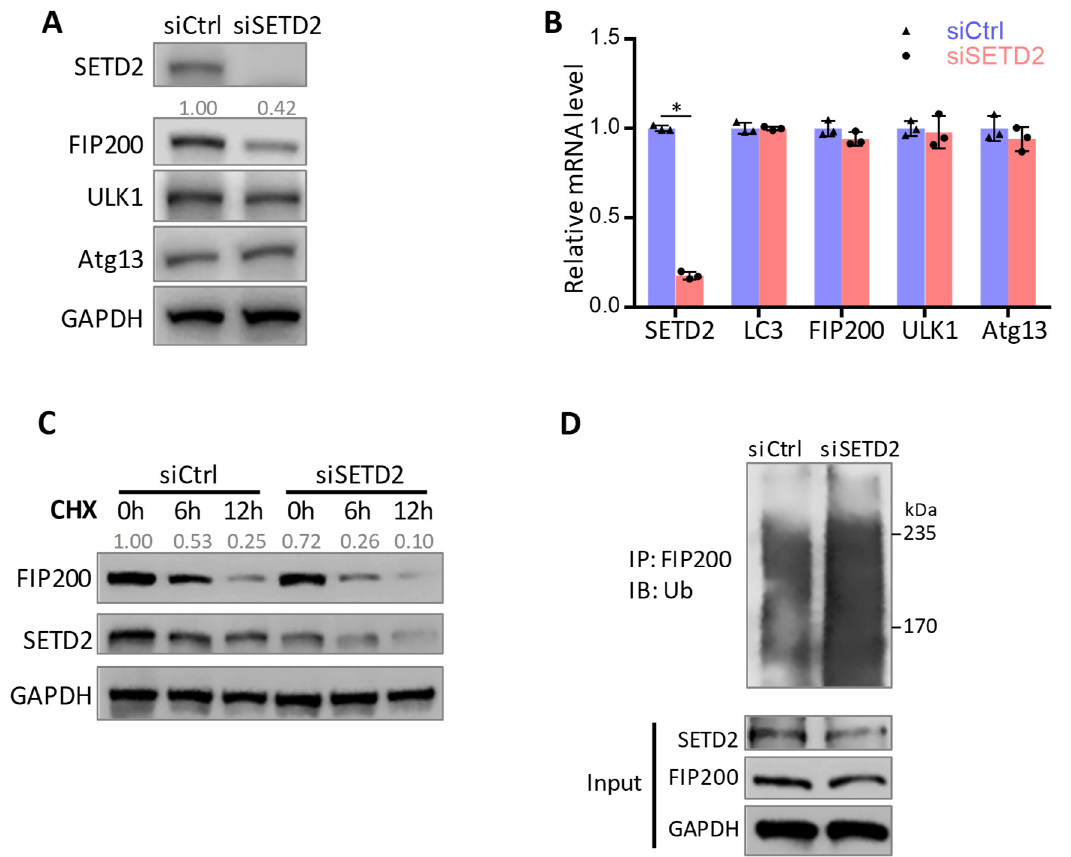
Figure 3. SETD2 maintains FIP200 protein stability. ( A ) SETD2 inactivation resulted in a reduced FIP200 protein level. Expression levels of autophagy initiation complex components were assessed by immunoblot in Hela cells transfected with SETD2 siRNA or scramble siRNA. FIP200 was quantified and normalized to GAPDH. ( B ) RT-qPCR showed that mRNA levels of the autophagy-related genes were not affected by SETD2 knockdown. *: P < 0.05. ( C ) FIP200 protein stability was diminished by SETD2 knockdown, shown by Cycloheximide (CHX) chase assay. FIP200 was quantified and normalized to GAPDH. ( D ) FIP200